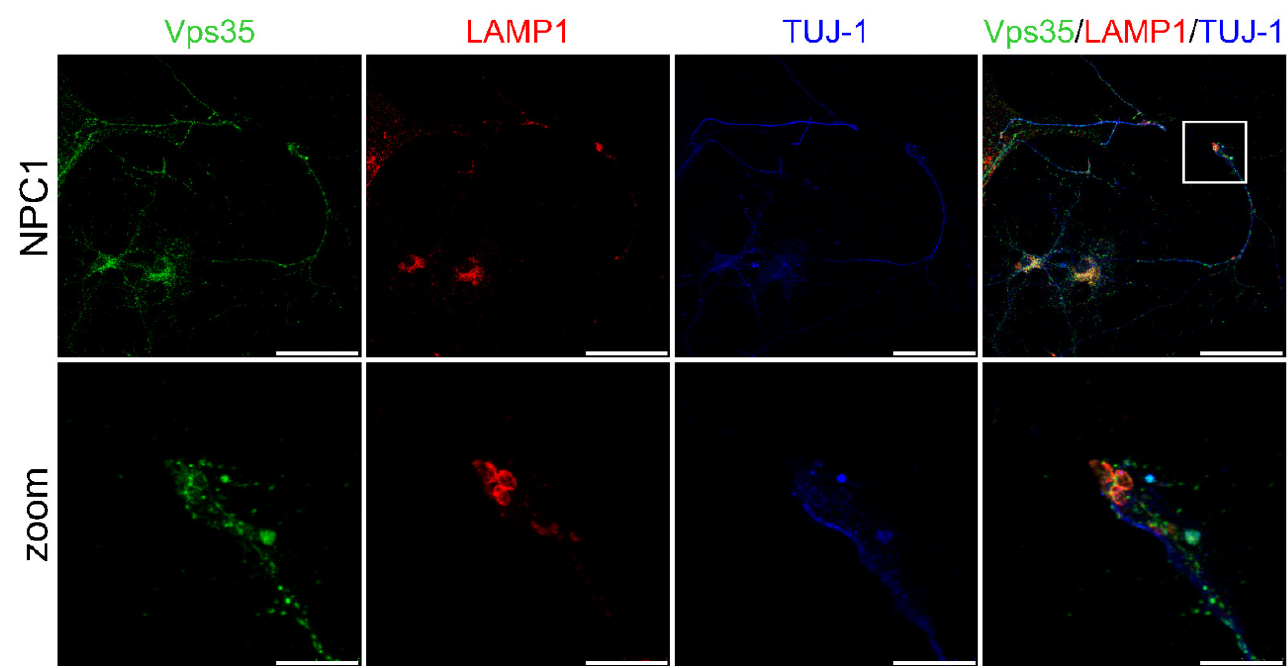
Figure 7. Vps35 is present in axonal swellings of hippocampal NPC1 neurons. Hippocampal neurons were isolated at postnatal day 0 (P0), grown in culture for 14 DIV, fixed and stained for Vps35 (green), lysosomal marker LAMP1 (red) and neuronal marker TUJ-1 (blue). Cells were analyzed using confocal microscopy. The axonal swelling is depicted by white square and in zoomed picture. Scale bar—50 (unzoomed) and 10 µm (zoom).